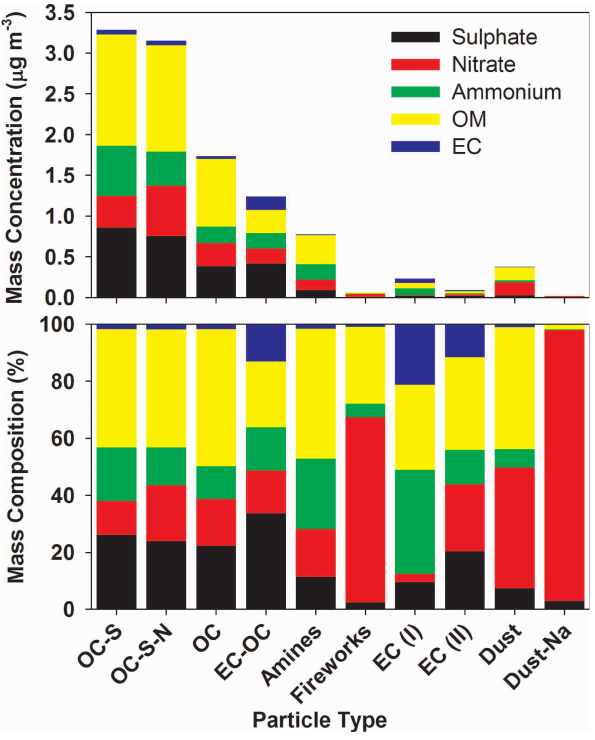
Fig. 8. Average mass concentration (A) and composition (B) of the five PM 2 . 5 chemical components in the 10 particle